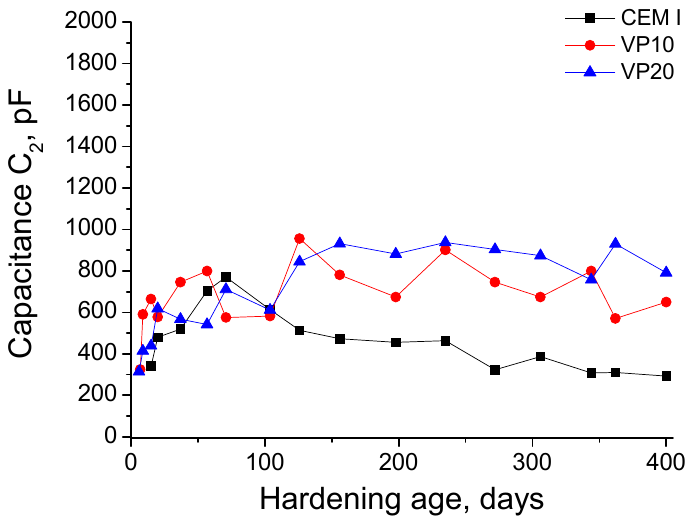
Figure 12. Impedance spectroscopy C 2 capacitance for the mortars studied.